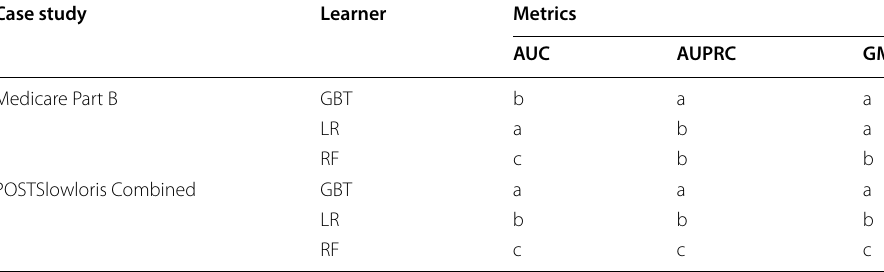
Table 7 Tukey’s HSD Test